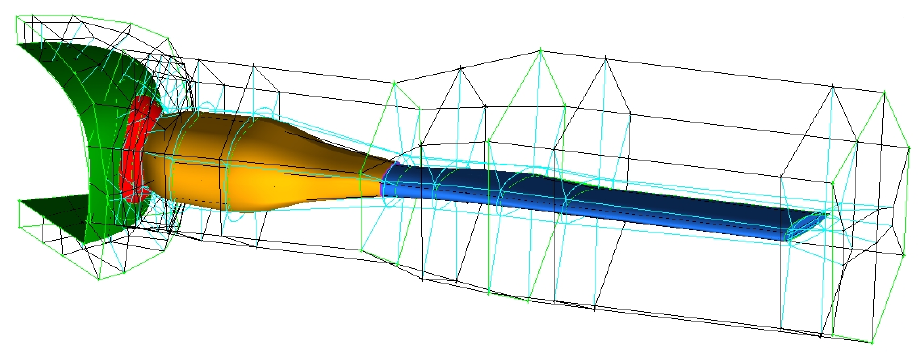
Figure 8. Blocking strategy of the rotor head components demonstrated by the beanie and the rotor blade mesh domain.